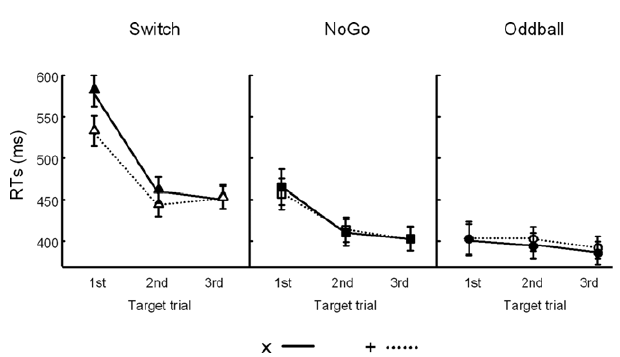
Figure 3. Behavioral results. Mean reaction times (RTs) and SEM to visual targets as a function of their sequential position following black symbols in the 3 task conditions.